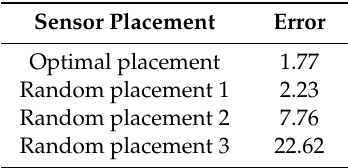
Table 7. Reconstruction errors (%) for 9 positions.